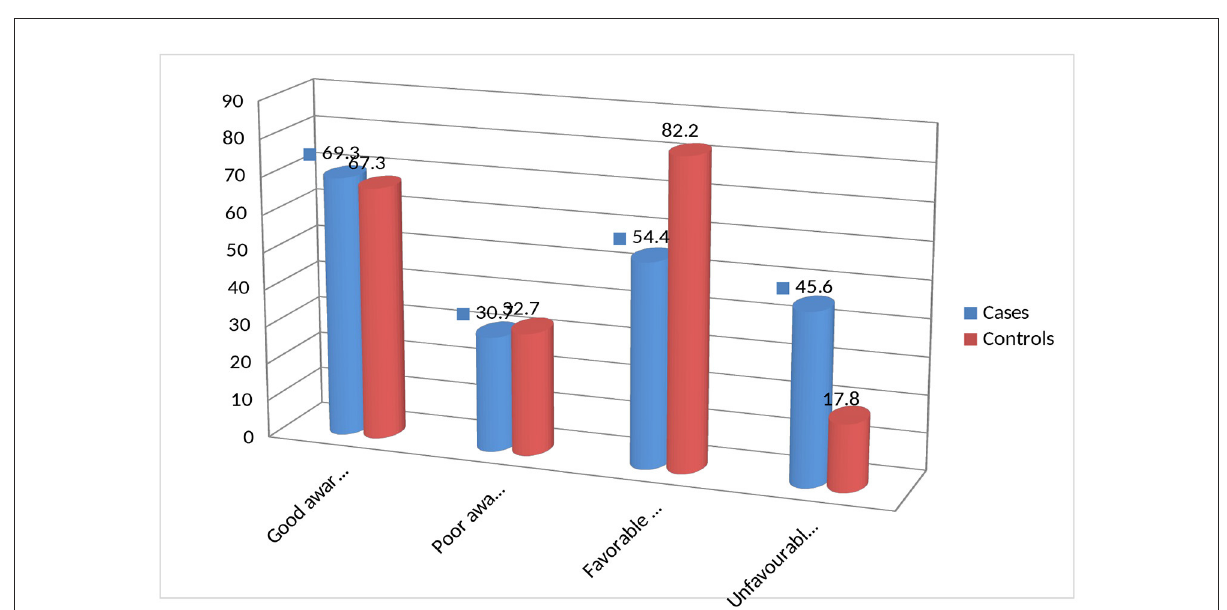
FIGURE2 Awareness and attitudes of rural household heads toward CBHI as factors influencing dropout of HH from CBHI in rural districts of Gurage Zone, southwest Ethiopia, 2021.